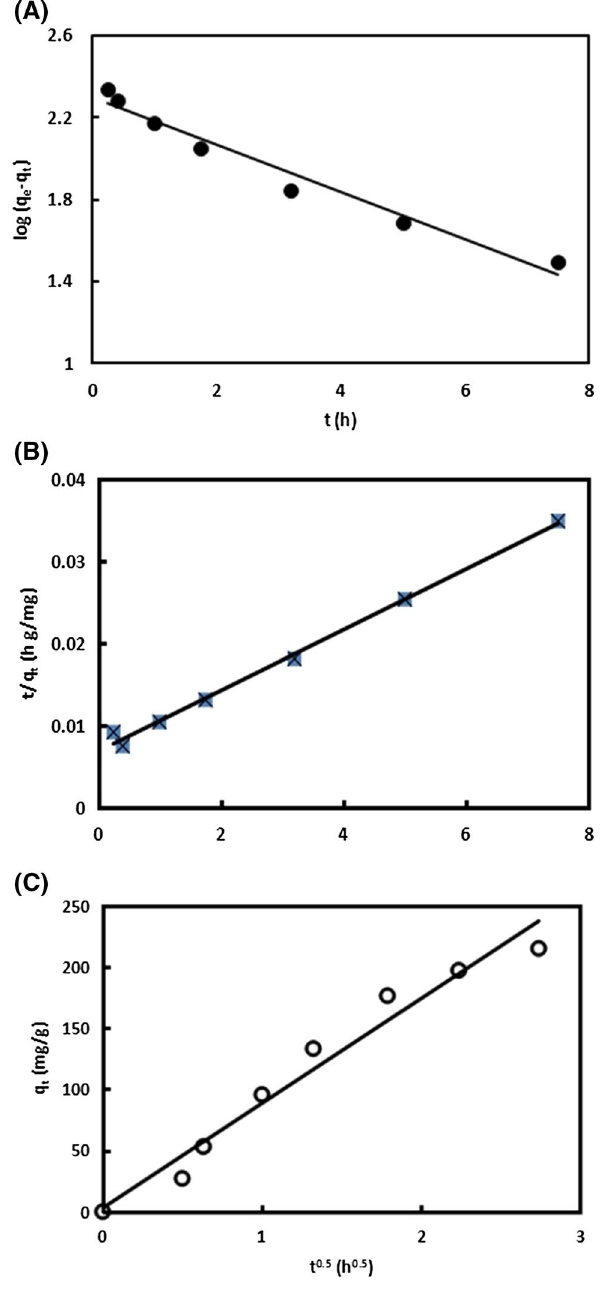
Fig. 9 a Pseudo-first-order, b pseudo-second-order and c intra-parti- cle diffusion kinetic plots for 2,4,6-TCP adsorption onto CSSS-AC at 30